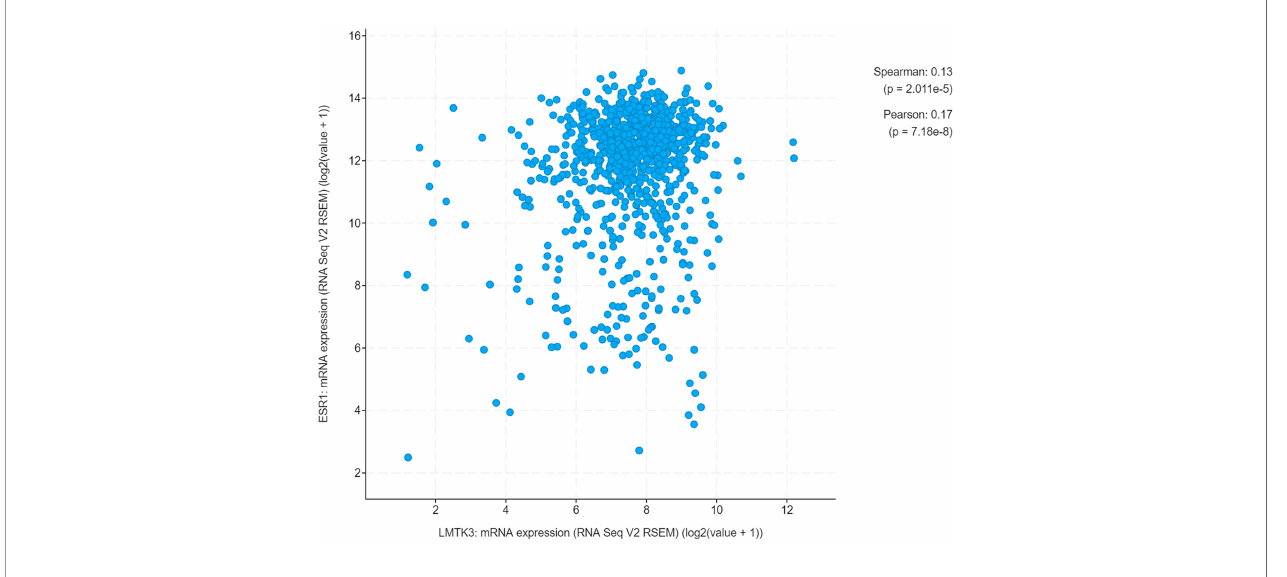
FIGURE 5 | A positive correlation between the mRNA expression of LMTK3 and ESR1 .